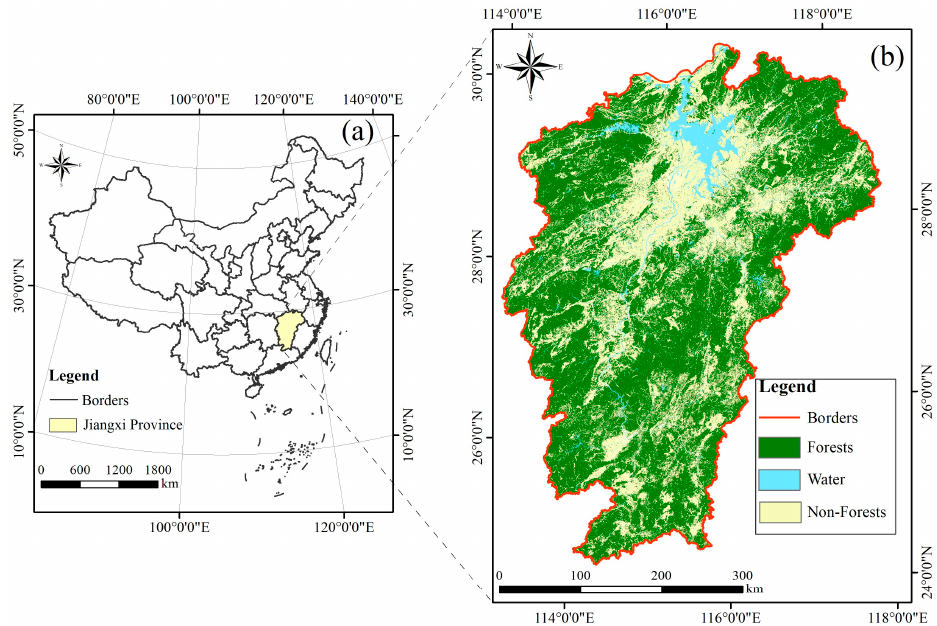
Figure 1. ( a ) Location of the study area in China. ( b ) Land cover, including forest, water, and non-forest, in the study area.